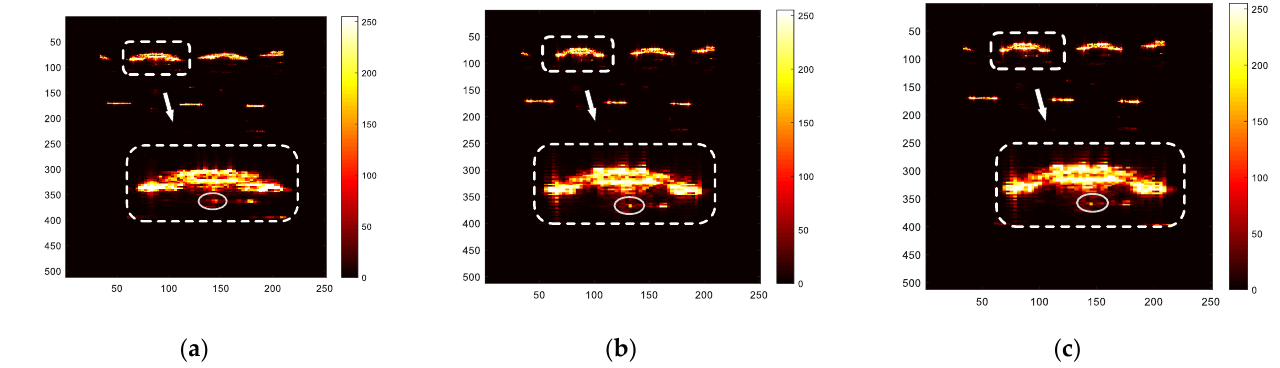
Figure 16. Comparative results of actual data. ( a ) The traditional RDA; ( b ) The proposed method with segmented RCMC; ( c ) FFBPA.